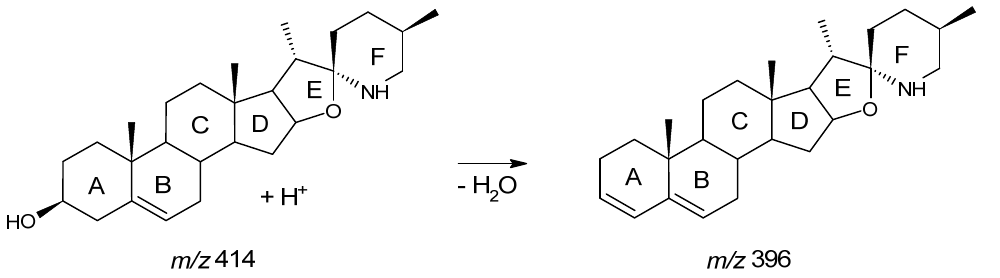
Figure 2. The fragmentation of solasodine ( m / z = 414) to [solasodine—H 2 O] ( m / z = 396) after the loss of water. Table 1. Experiments designed by CCD for ATPE optimization with the respective responses and predicted values.